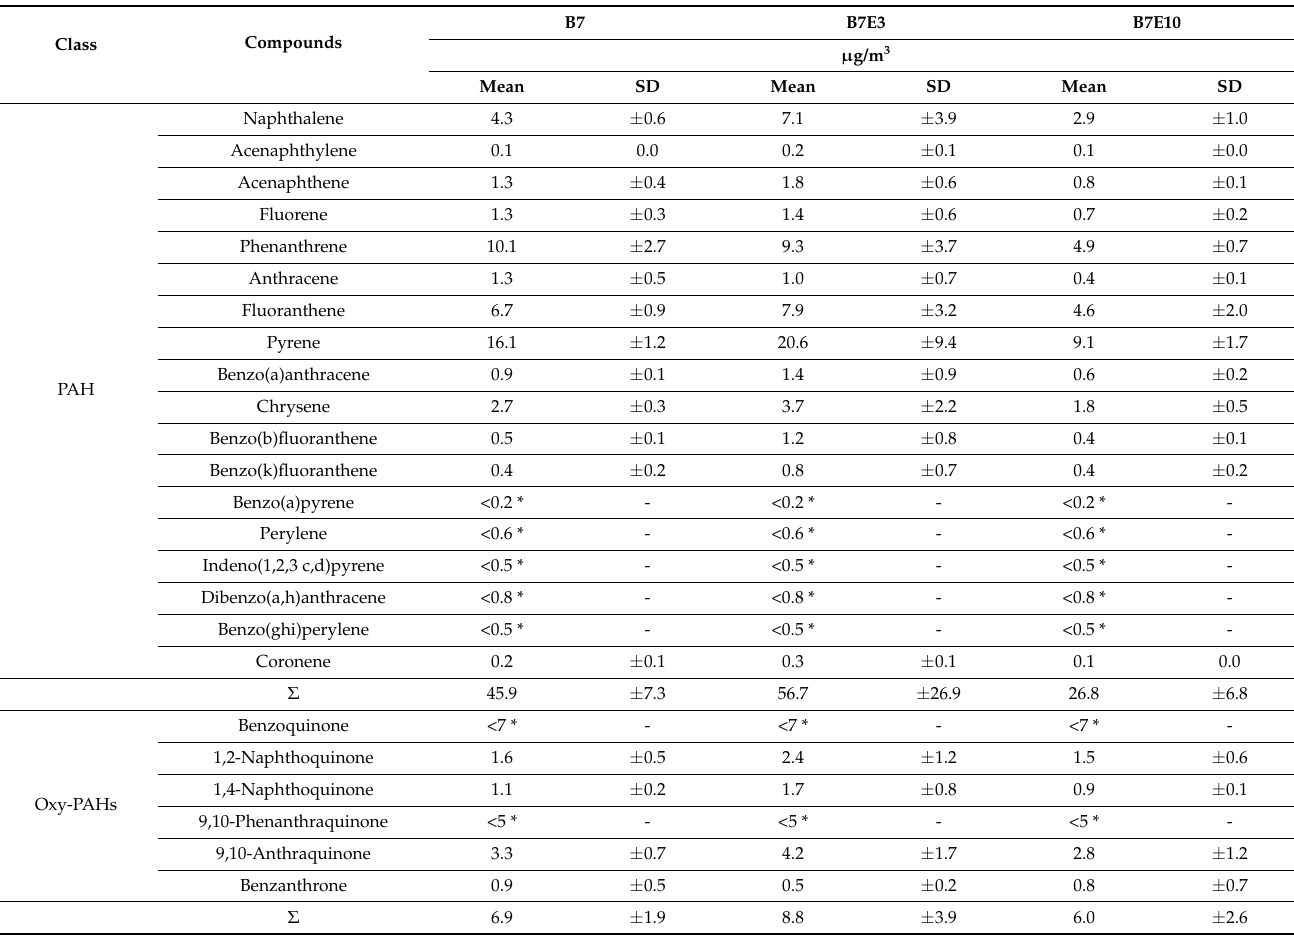
Table 4. Concentrations of PAH, quinones, and nitro-PAH ( µ g m − 3 ) in PM 2.5